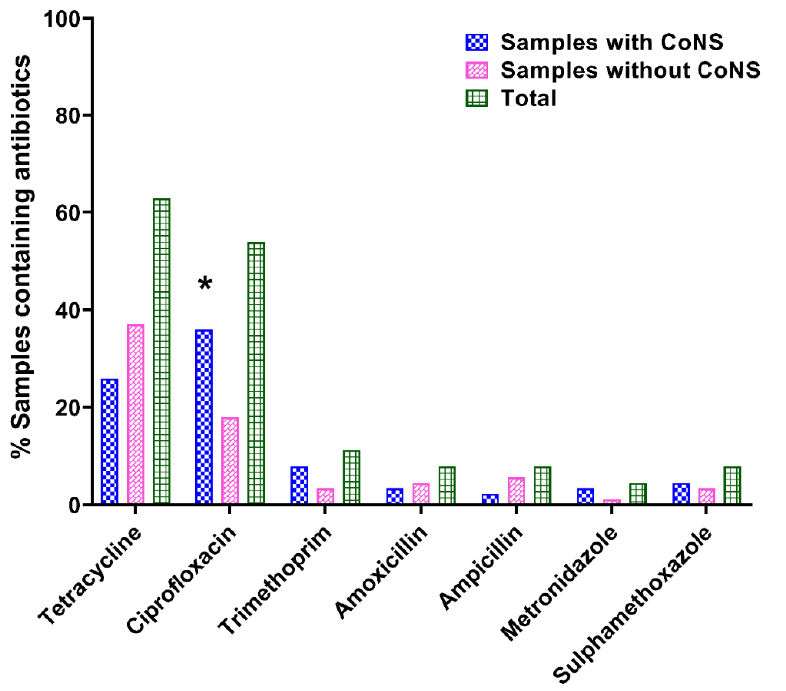
Figure 3. Presence of individual antibiotics in urine samples of participants, shown by the presence of CoNS. Statistical analysis by two-way ANOVA with Sidak’s post-test showed a significant difference in the samples with and without CoNS containing ciprofloxacin: * p < 0.05. Out of the 89 samples showing the presence of antibiotics, 75 of them (84.3%) had quantifiable levels of the antibiotics: 36 (48.0%) from KG and 39 (52.0%) from DDW. A considerable number of these samples contained quantifiable levels of one (57.3%, n = 43), two (30.7%, n = 23), three (8.0%, n = 6), four (2.7%, n = 2), and five (1.3%, n = 1) of the antibiotics. The general observation was that a similar number of samples from both KG and DDW contained more than one quantifiable residual level of antibiotics (50.0%, n = 16). The analysis further showed that the residual levels of the antibiotics were significantly different from each other ( H = 27.02, p = 0.0001), with metronidazole ( n = 3) recording the highest median concentration (167 ng mL −1 ), followed by tetracycline ( n = 41, 26.7 ng mL −1 ), and ciprofloxacin ( n = 48, 14.6 ng mL −1 ). Trimethoprim ( n = 9), on the other hand, recorded the least median concentration (2.91 ng mL −1 ). The concentrations of antibiotics determined are summarized in Figure 4.